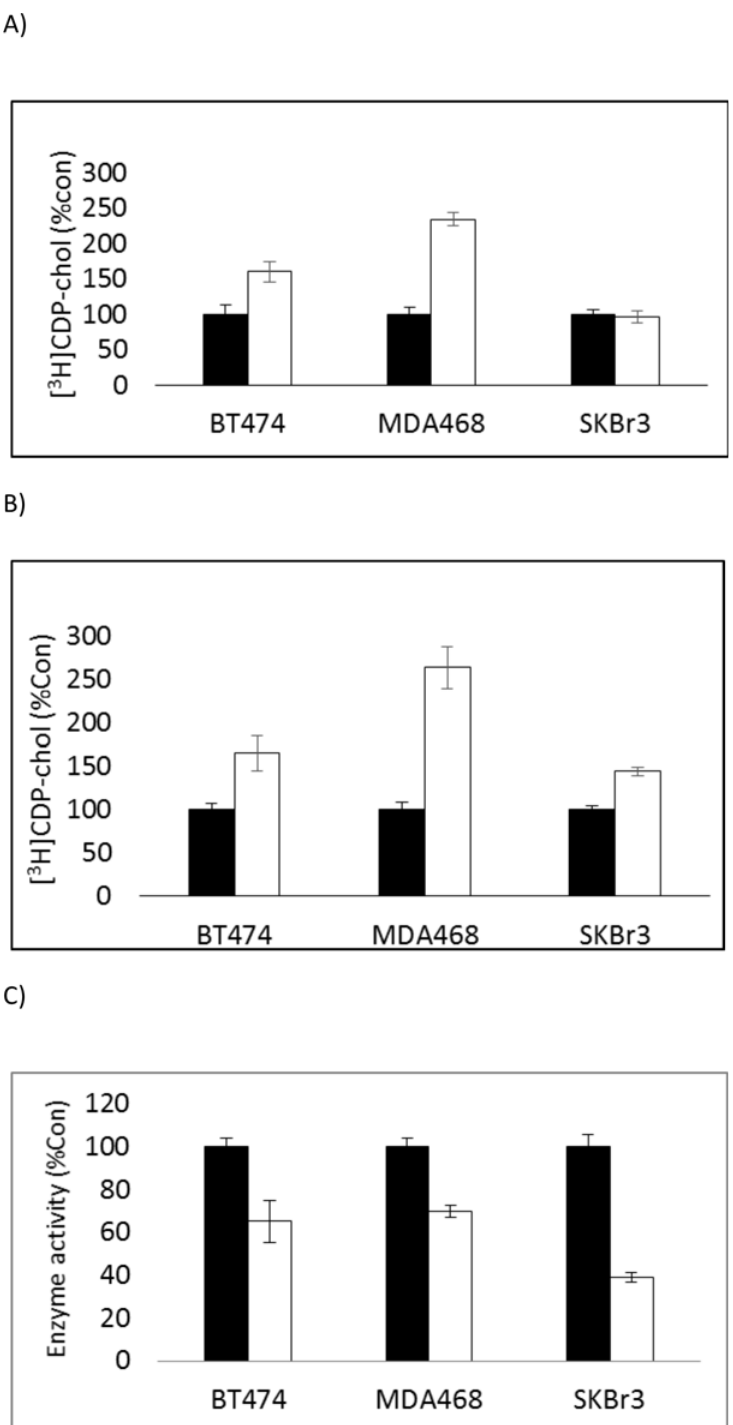
Fig 3. Total (A) and membrane (B) CTP:PCho cytidylyltransferase (CCT) and PtdCho-specific phospholipase C (C) activity of untreated (black) and metformin-treated (white) breast tumour cells. (units: CCT- [ 3 H]CDP-choline (CDP-chol) formed after 1h incubation with [ 3 H]PCho normalised to protein content and expressed relative to untreated cells; PLC – enzyme units normalised to protein content and expressed relative to untreated